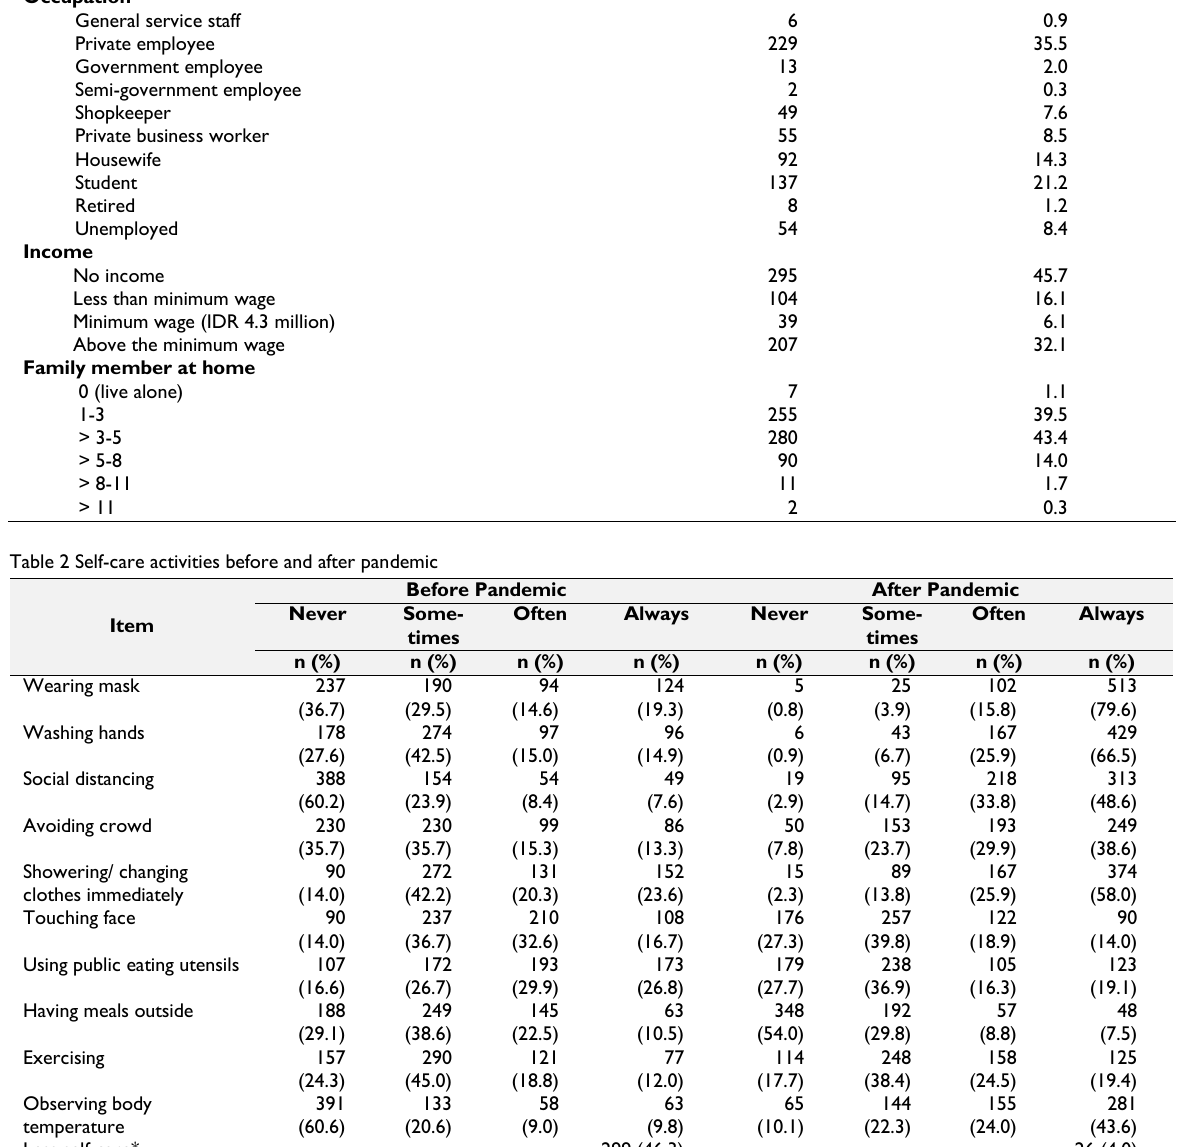
Early adulthood (17-40 y.o.)